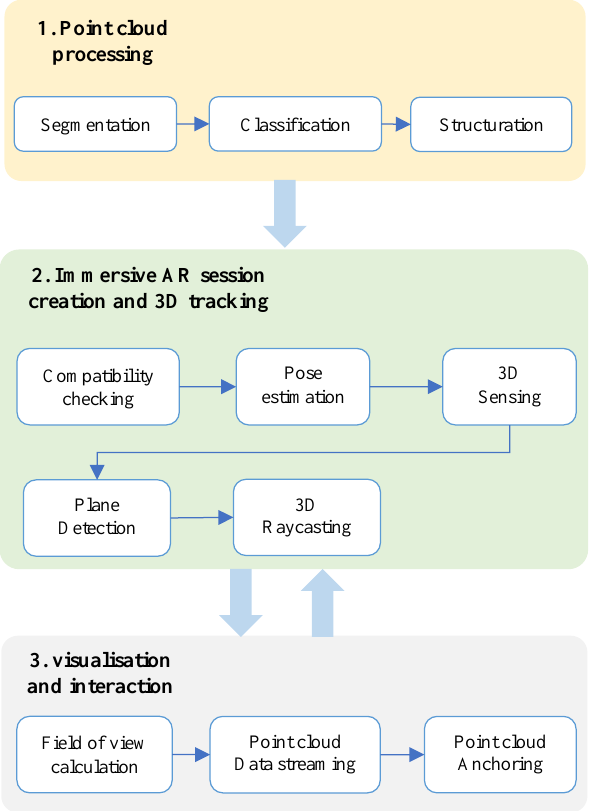
Figure 4. A general workflow of the followed methodology